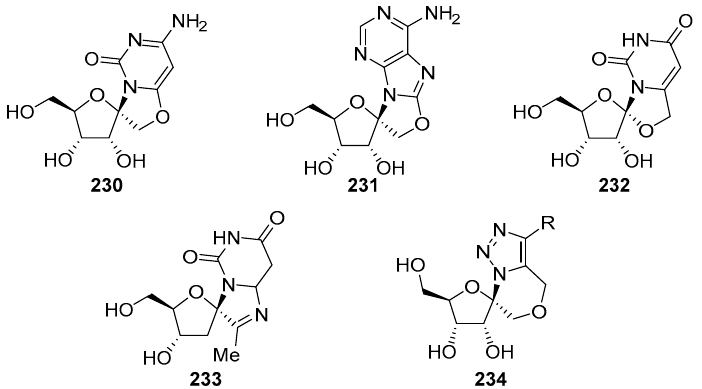
Figure 10. Polycyclic spironucleosides.